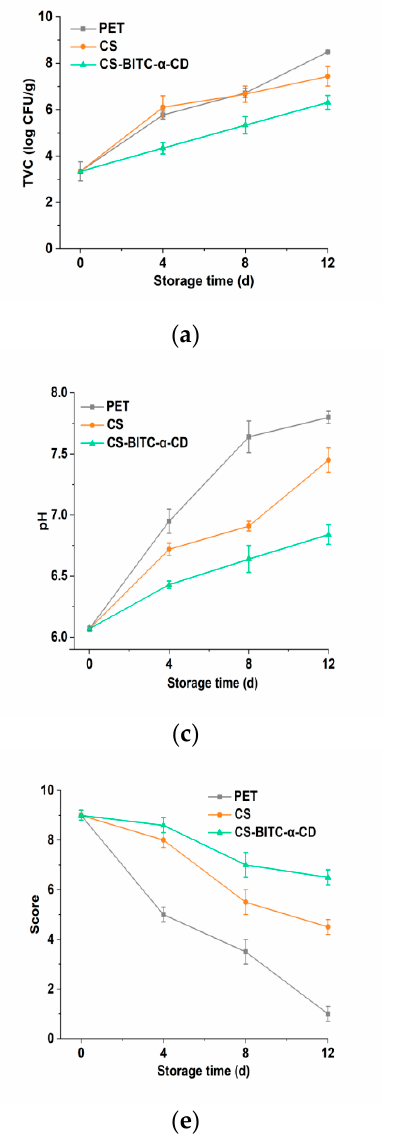
Figure 4. Changes of beef samples wrapped with pure CS and CS − based composite films during storage. ( a ) TVC; ( b ) TVB − N; ( c ) pH; ( d ) TBARS; ( e ) sensory evaluation. storage. ( a ) TVC; ( b ) TVB − N; ( c ) pH; ( d ) TBARS; ( e ) sensory